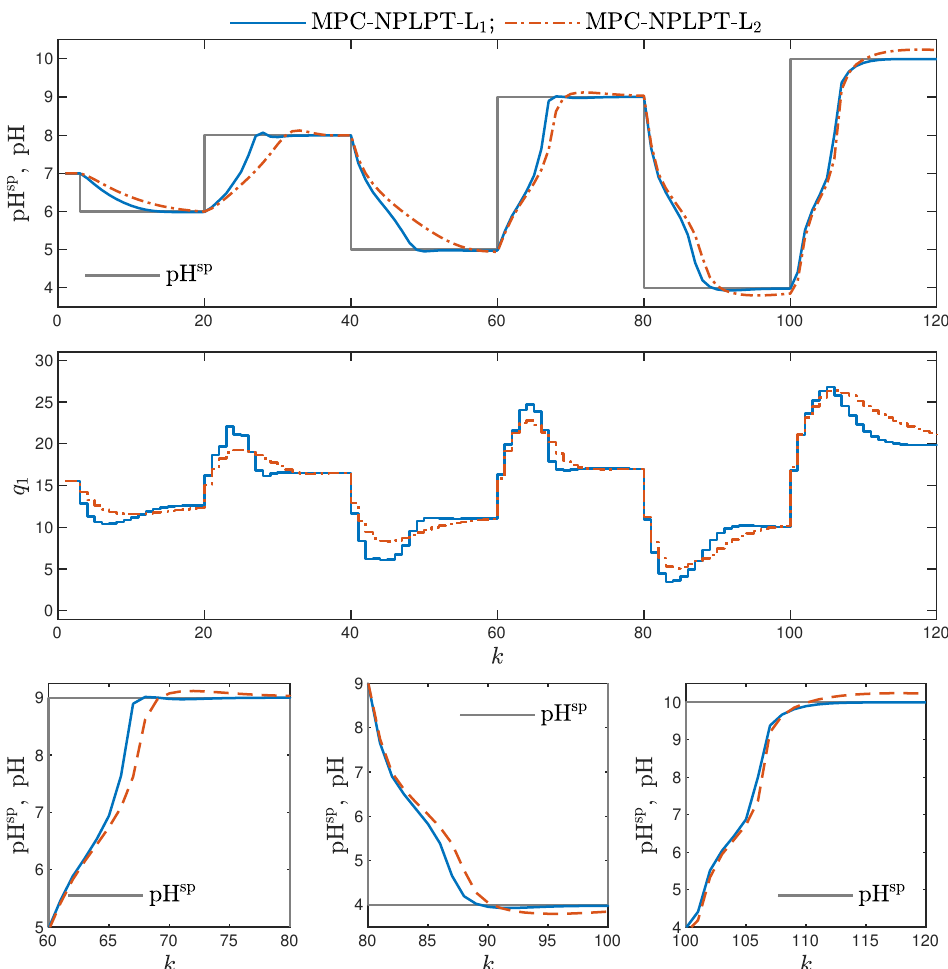
Figure 9. Simulation results: the MPC-NPLPT-L 1 algorithm vs. MPC-NPLPT-L 2 algorithm, in both cases λ = 5; two top panels show the results for the whole simulation horizon, three bottom panels show enlarged fragments for the sampling instants 60 ≤ k ≤ 80, 80 ≤ k ≤ 100 and 100 ≤ k ≤